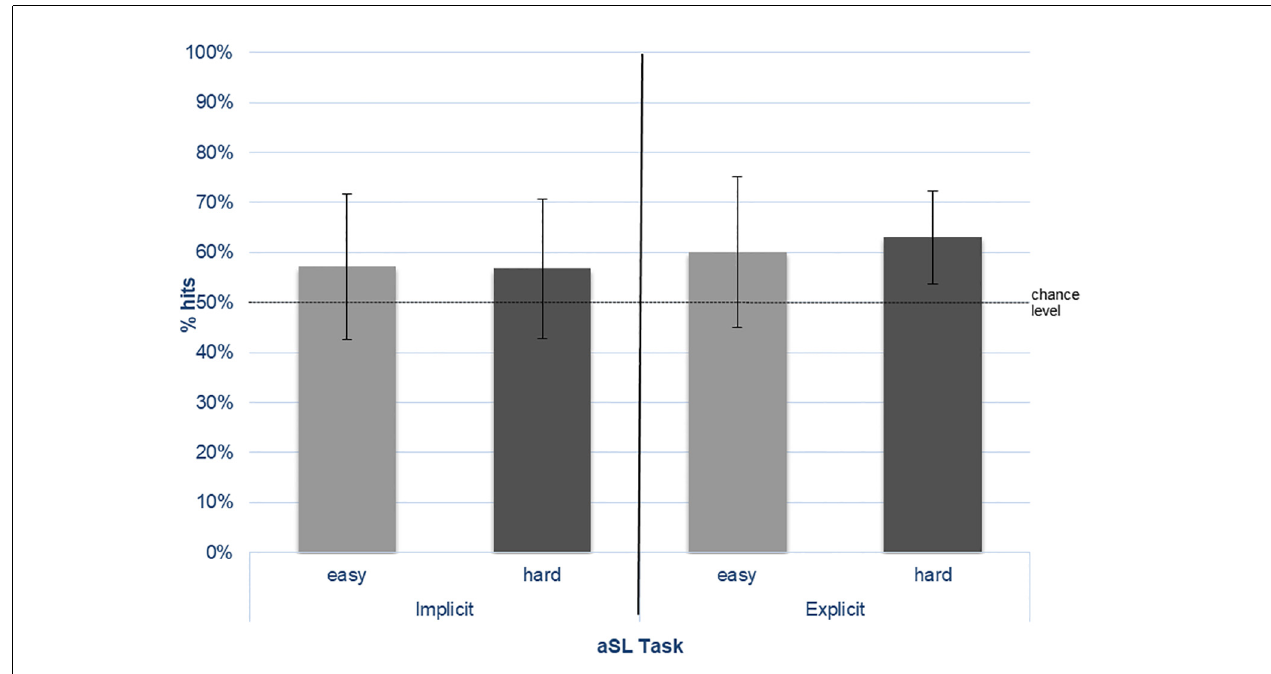
FIGURE 2 | Percentage of correct choices (% hits) for the easy- and hard-nonsense words in the 2-AFC tasks performed under implicit and explicit